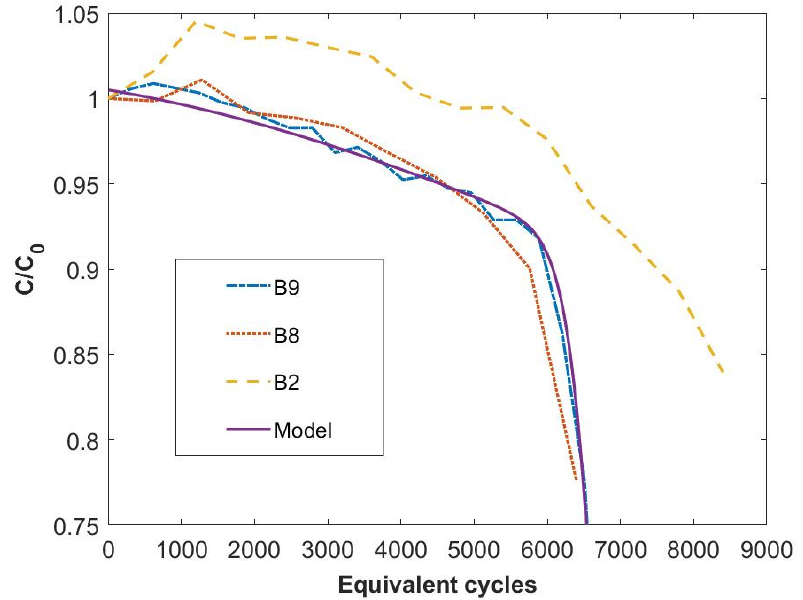
Figure 9. Degradation curve of the capacity for cell B9 with respect to the number of equivalent cycles and the comparison between the predictions of the model (8). For comparison, the curves of batteries 8 and 2 are shown.